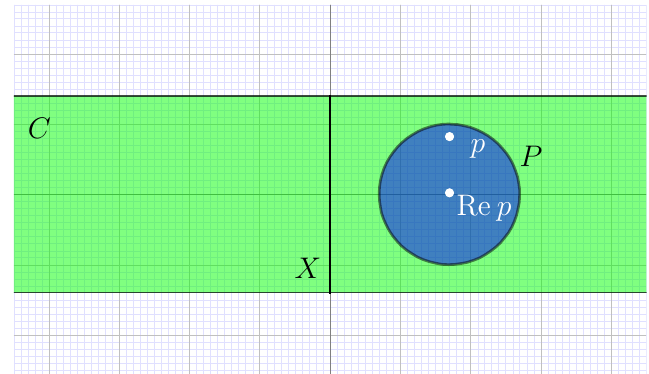
Figure 9 . Schematic picture of the tube C and polydisk P